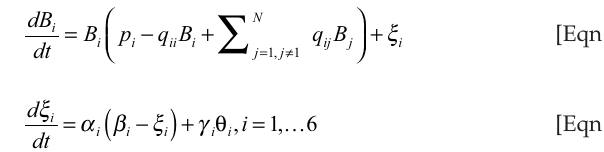
( t ) (asset bidding 2), t ∈ [ t 2